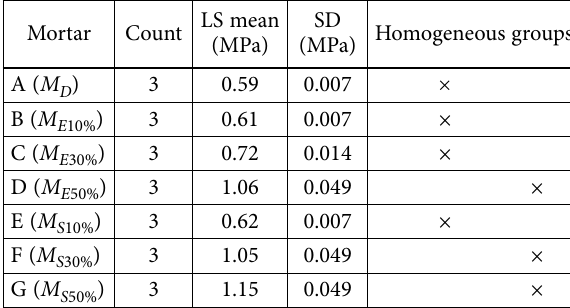
Table 3. Multiple Range Test for rough oblique surface adhesive strength of hardened mortar by mortar type. Method: 95% LSD LS mean Mortar Count (MPa)